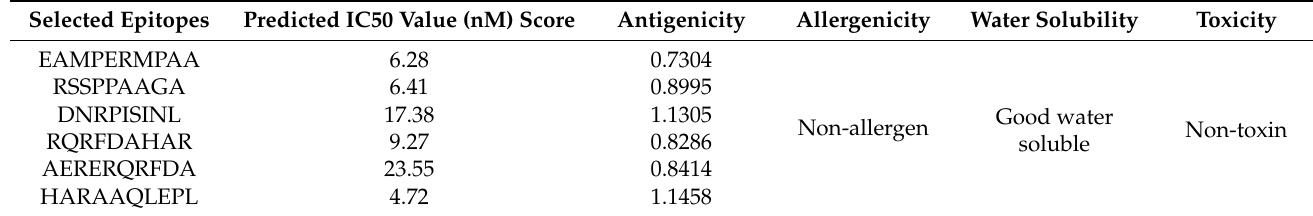
Table 3. Selected proteins and their good vaccine candidate properties.